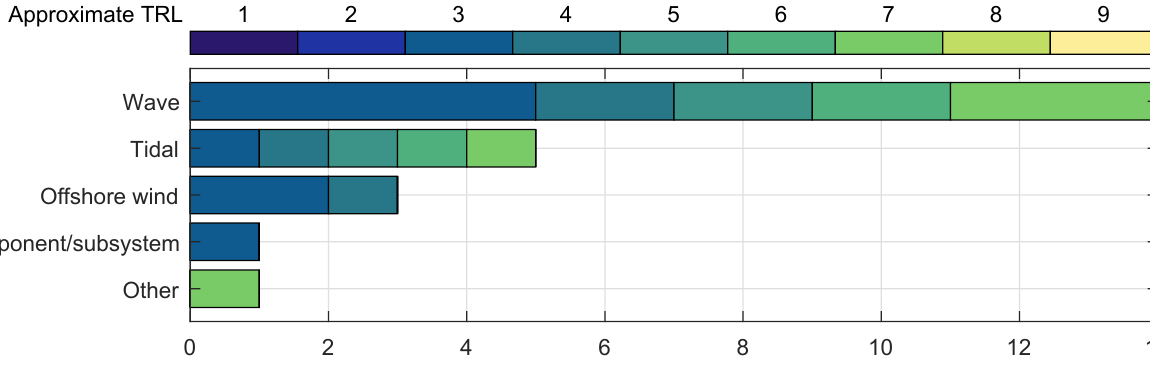
Figure 2. Breakdown of technology developer responses by technology(s) and approximate